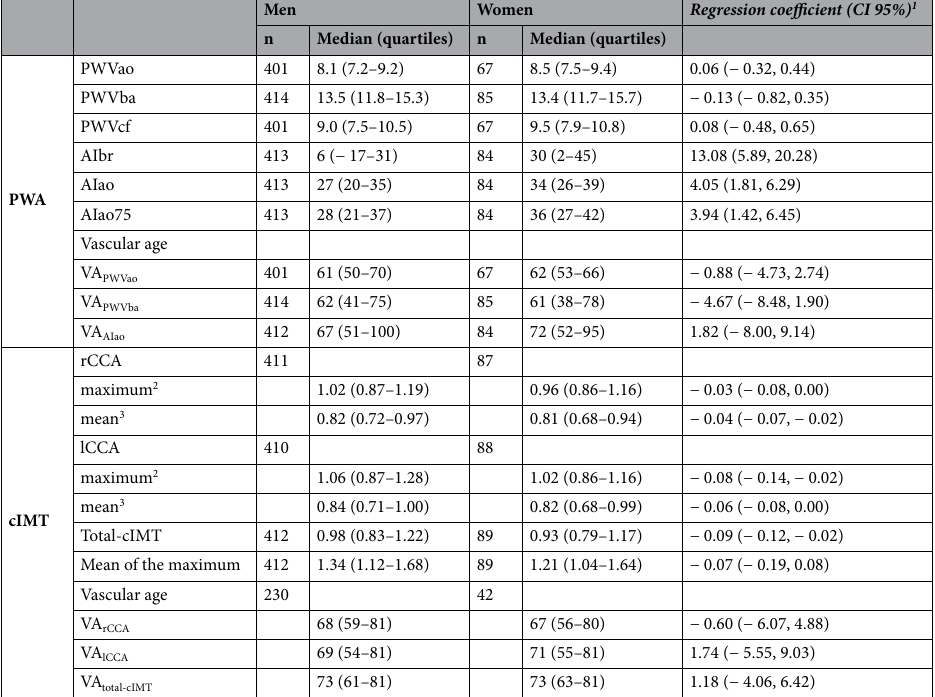
Table 2. Results of the PWA and the cIMT measurement. PWA pulse wave analysis, cIMT carotid intima- media thickness, PWVao aortic pulse wave velocity, PWVba brachial-ankle pulse wave velocity, PWVcf carotid- femoral pulse wave velocity, AIbr brachial augmentation index, AIao aortic augmentation index, AIao75 aortic augmentation index standardised to a heart rate of 75 bpm, VA Vascular age, rCCA right common carotid artery, lCCA left common carotid artery. 1 linear regression for PWVao, PWVcf, AIbr, AIao and AIao75, censored regression for VA rCCA , VA lCCA and VA total-cIMT and quantile regression for PWVba, VA PWVao , VA PWVba , VA AIao , rCCA-cIMT, lCCA-cIMT, total-cIMT and mean of the maximum cIMT; age-adjusted. 2 maximum value over a length of 10 mm. 3 mean value over a length of 10